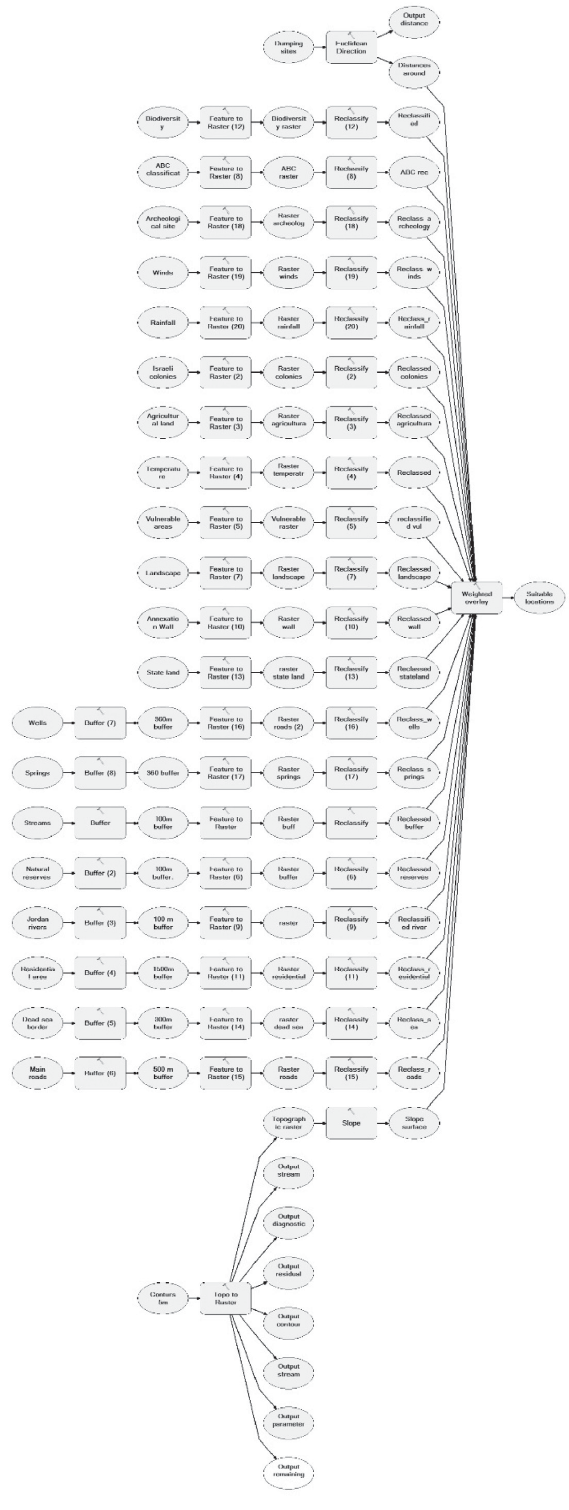
Figure 3: GIS modeling of the methodology used to find the most suitable locations for landfills.